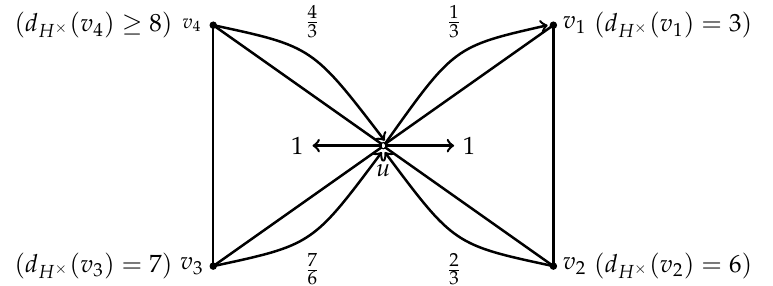
Figure 1. A specific example about the charge change of the false 4-vertex u